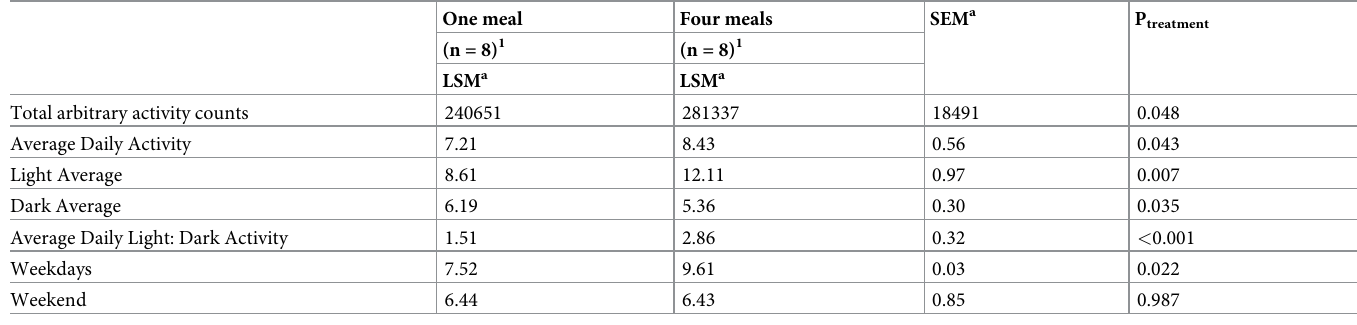
Table 6. Voluntary physical activity (arbitrary activity counts) of cats eating once (0800 h) or four times (0800 h, 1130 h, 1500 h, 1830 h) daily consisting of six con- secutive days of data for each treatment. One meal Four meals SEM a P treatment (n = 8)